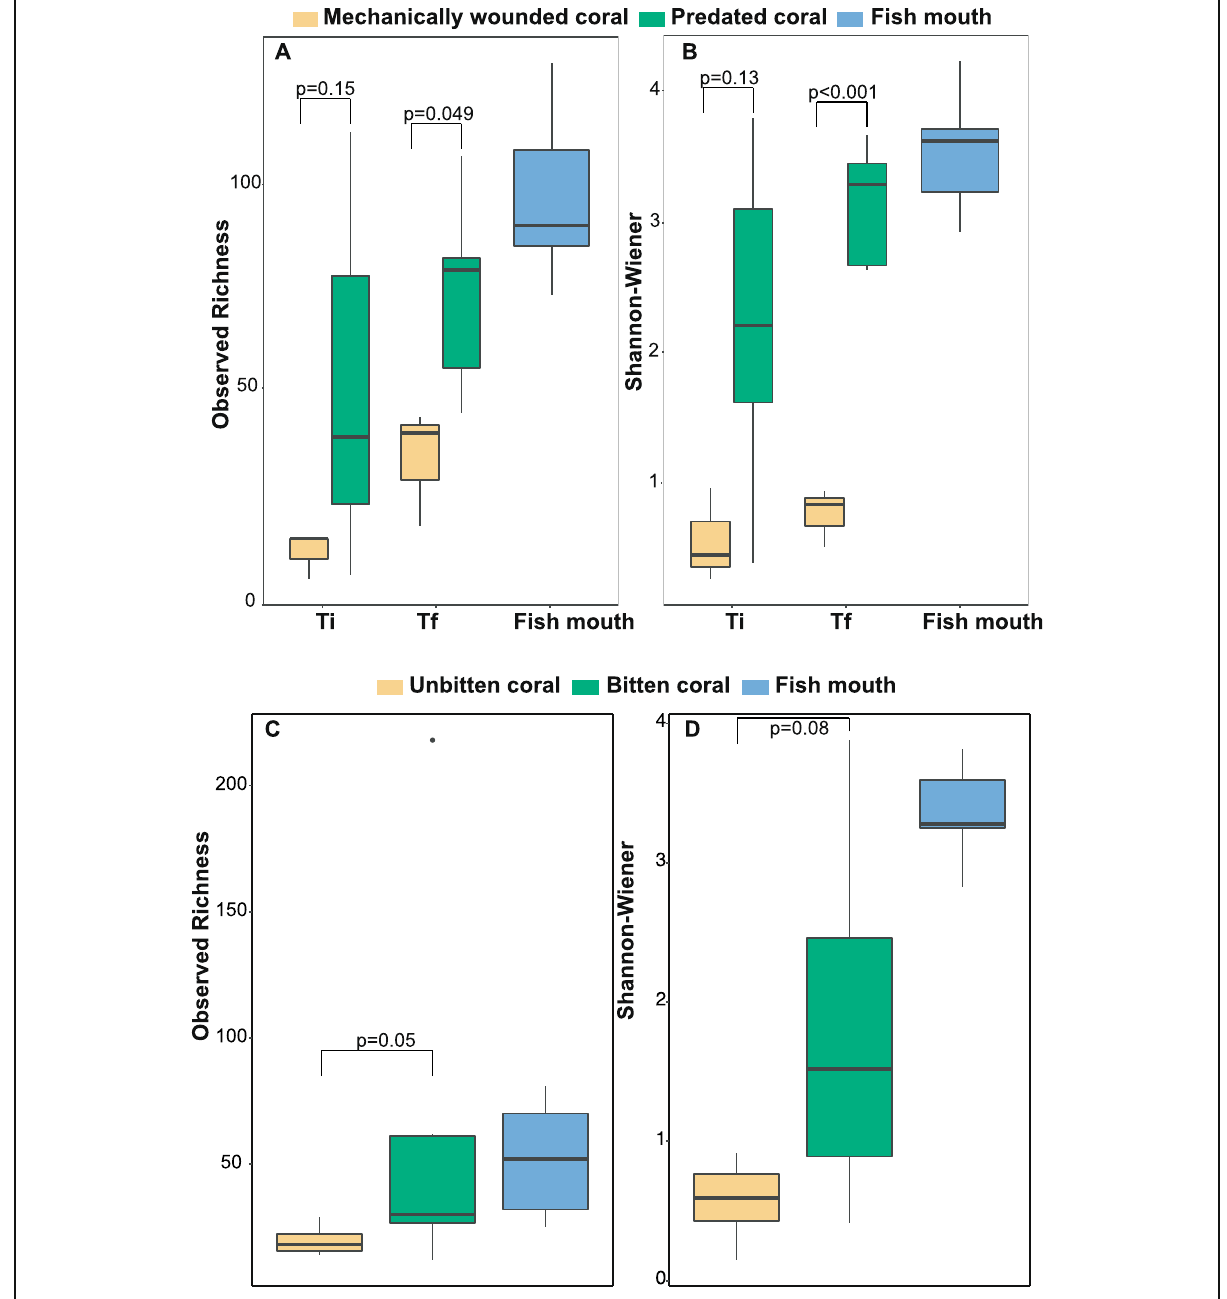
Fig. 3 Alpha diversity metrics. Observed richness and Shannon-Wiener diversity indices for the mesocosm experiment ( a , b ) and field survey ( c , d ) for each sample type and timepoint. P -values represent pairwise comparisons, using Tukey ’ s or Dunn ’ s test, at each time point between a ,